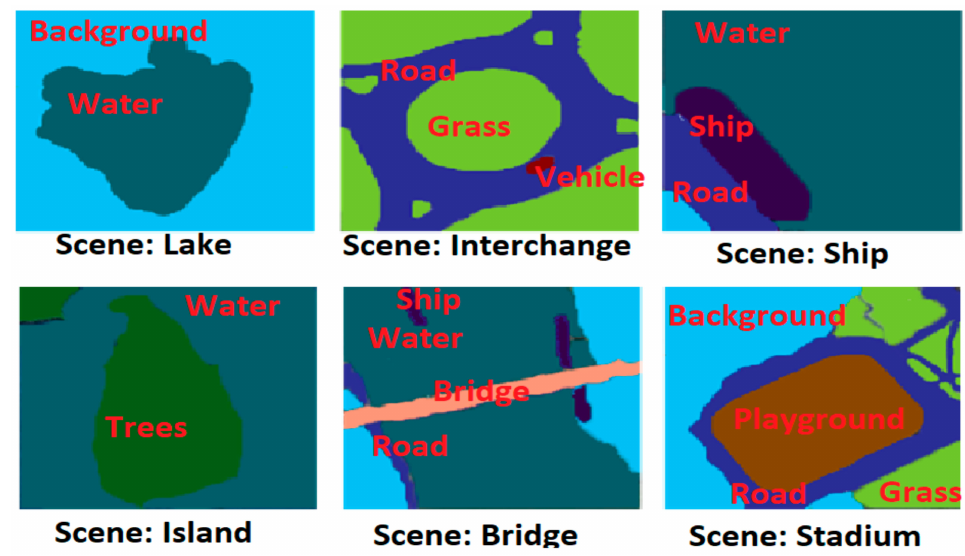
Figure 9. Scene recognition results over RESISC45 dataset by applying fully convolutional network through categorized objects and analyzed object-to-object relations.